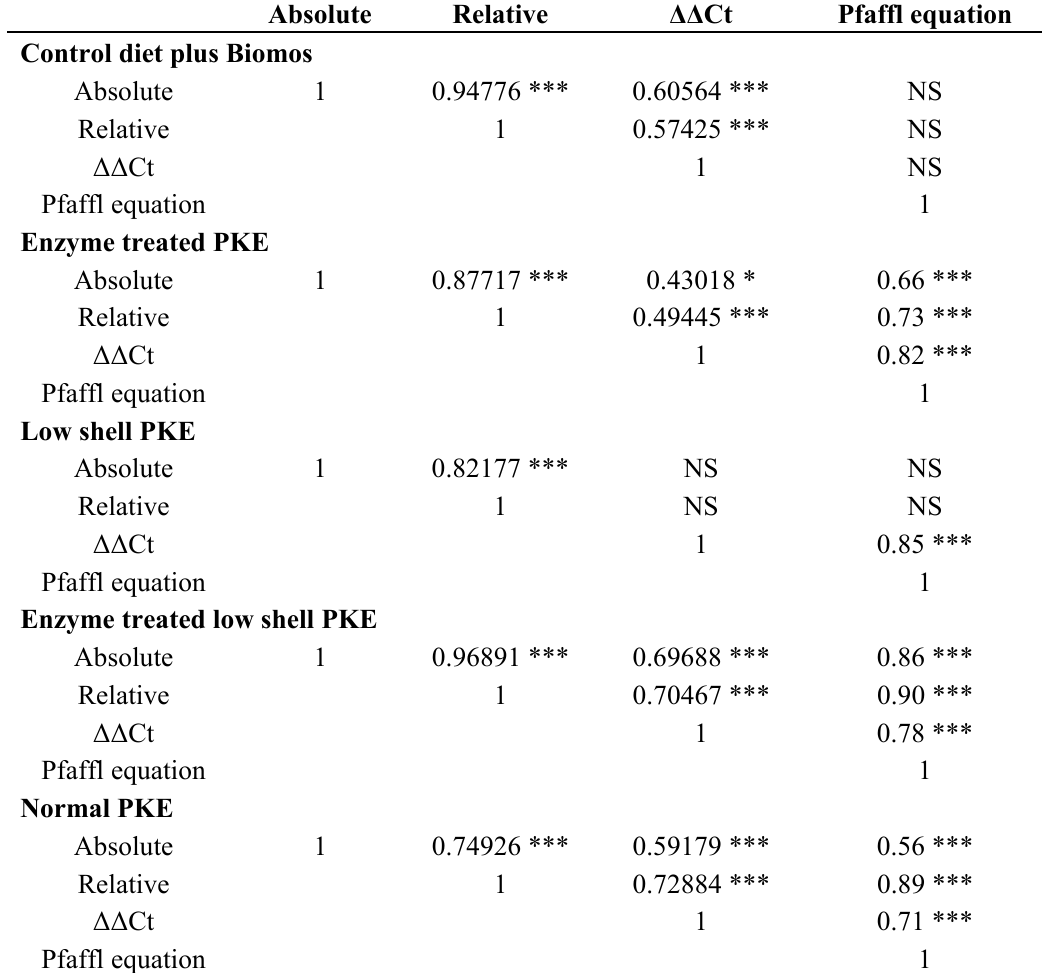
Table 3. Correlation coefficients between three methods in different dietary